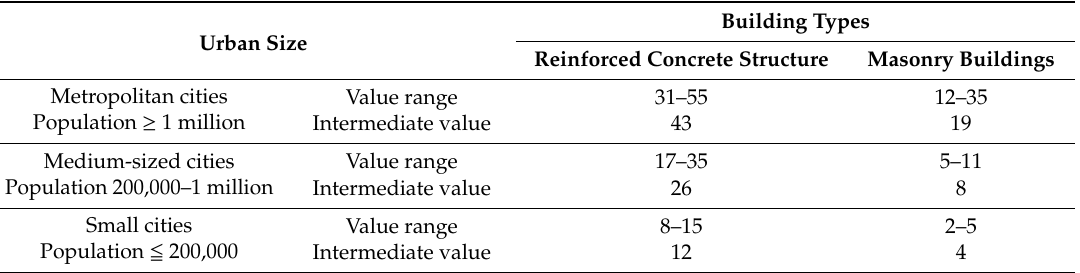
Table 5. The value ranges for the ratio coe ffi cient of a construction area of mid-to-high-end indoor decorations to the total construction surface area of the building (unit: %)